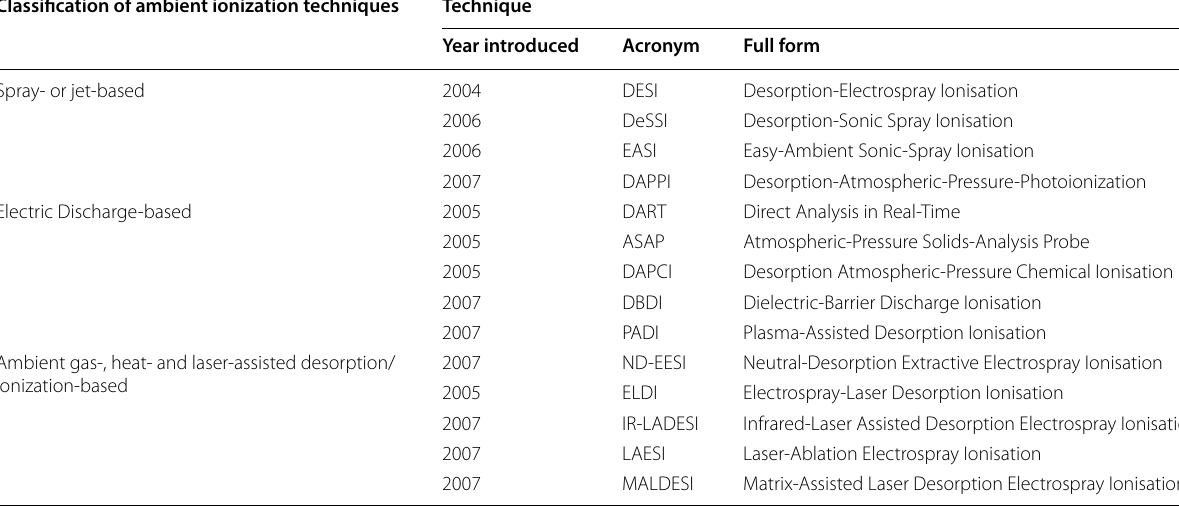
Table 1 Categorization of ambient ionization techniques (Harris and Nyadong 2008) Classification of ambient ionization